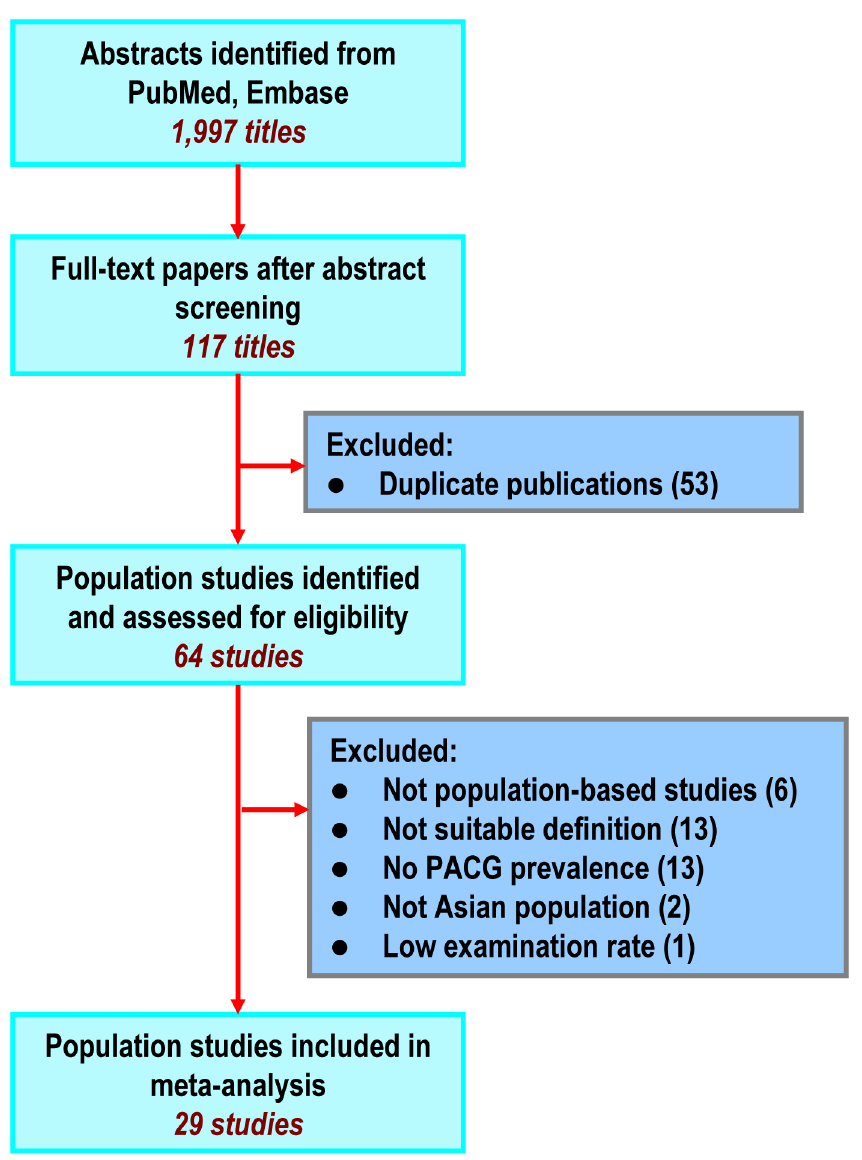
Figure 1. Flow Diagram of Study Selection. PACG: primary angle closure glaucoma